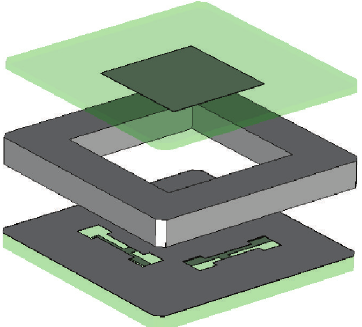
Figure 8: Dual polarization radiating